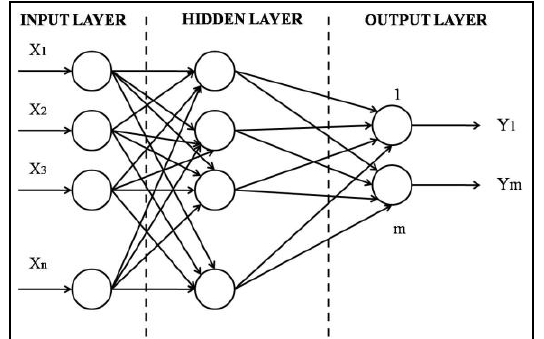
Figure 5. Architecture of a MLP neural network.